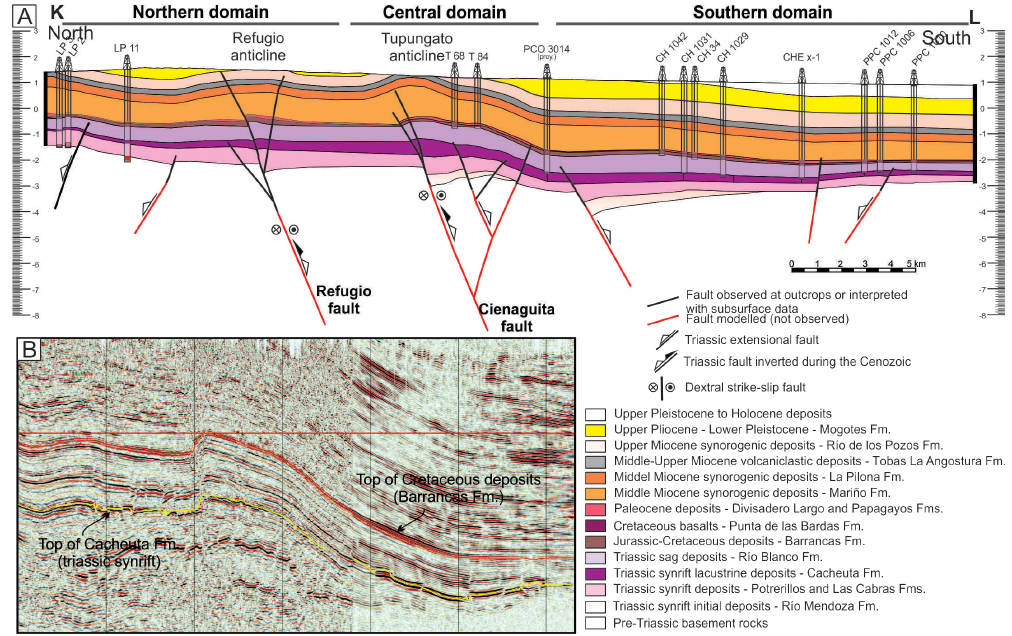
Figure 9. (a) The Pilona–Puesto Pozo Cercado regional N–S cross section, running from the northern to the southern domains. See location in Fig. 4. Observe the abrupt change in topographic and structural level (basement–cover interface) in the central domain, reflecting the effect of more horizontal shortening in the north than in the south. (b) Arbitrary seismic line obtained from 3-D seismic data running along the Pilona–Puesto Pozo Cercado cross section.